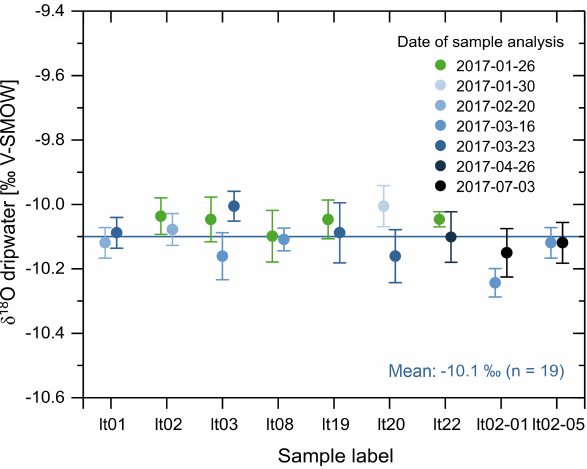
Figure 6. Results of repeated δ 18 O measurements (circles in tones of blue) measured in the automatically collected samples together with the original δ 18 O data from Fig. 5 (green circles) plotted against their respective label (“lt” stands for Laichinger Tiefen- höhle). The darker the tones of blue, the later the respective mea- surement was repeated. For interpretation of the references to color in this figure caption, the reader is referred to the web version of this